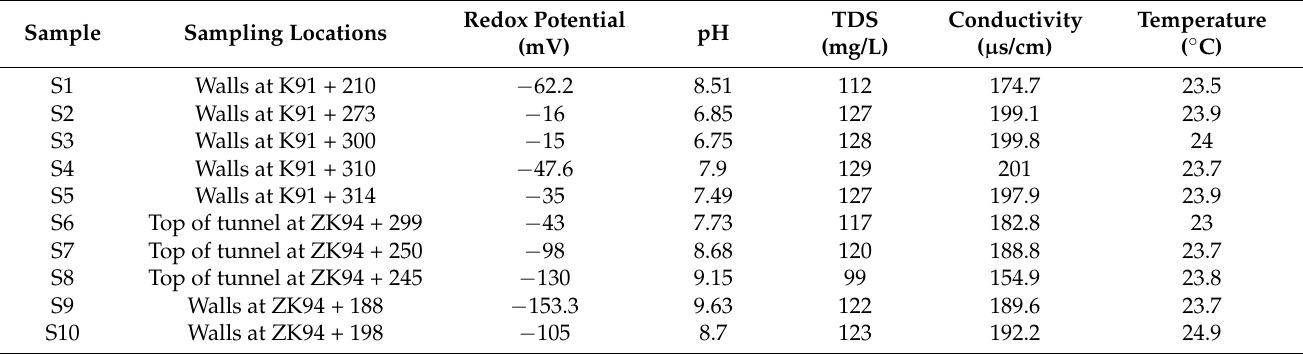
Table 1. Water quality characteristics of ten water gushing